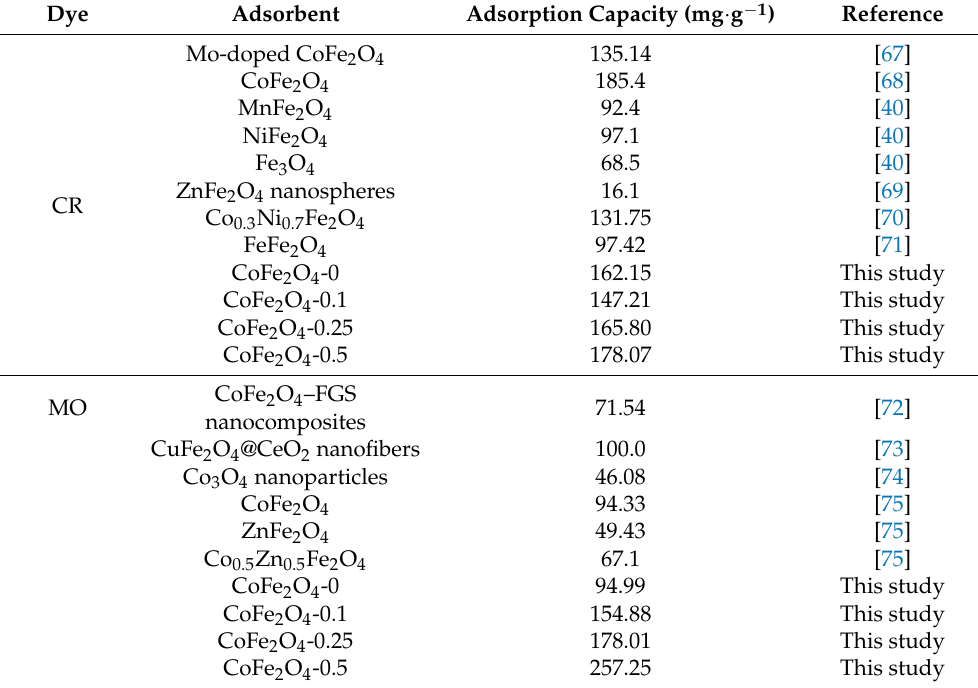
Table 9. Adsorption capacities of different adsorbents with spinel structure from the literature for the removal of CR and